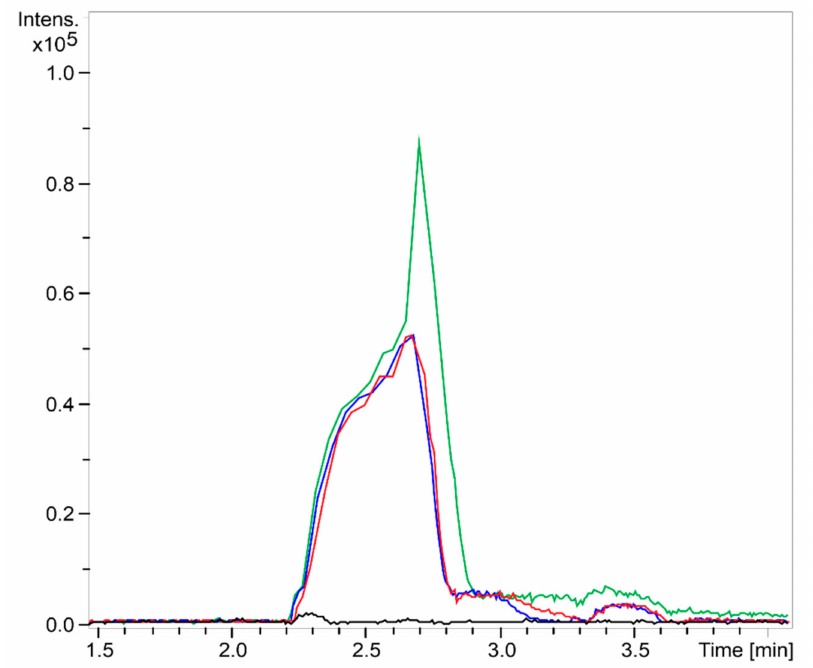
Figure 1. LC-MS/MS chromatograms (ESI-QTOF) obtained for the COS1 sample with an emphasis between 1.5 and 4 min. Black: chitosan; blue: COS1F1; red: COS1F2; green: